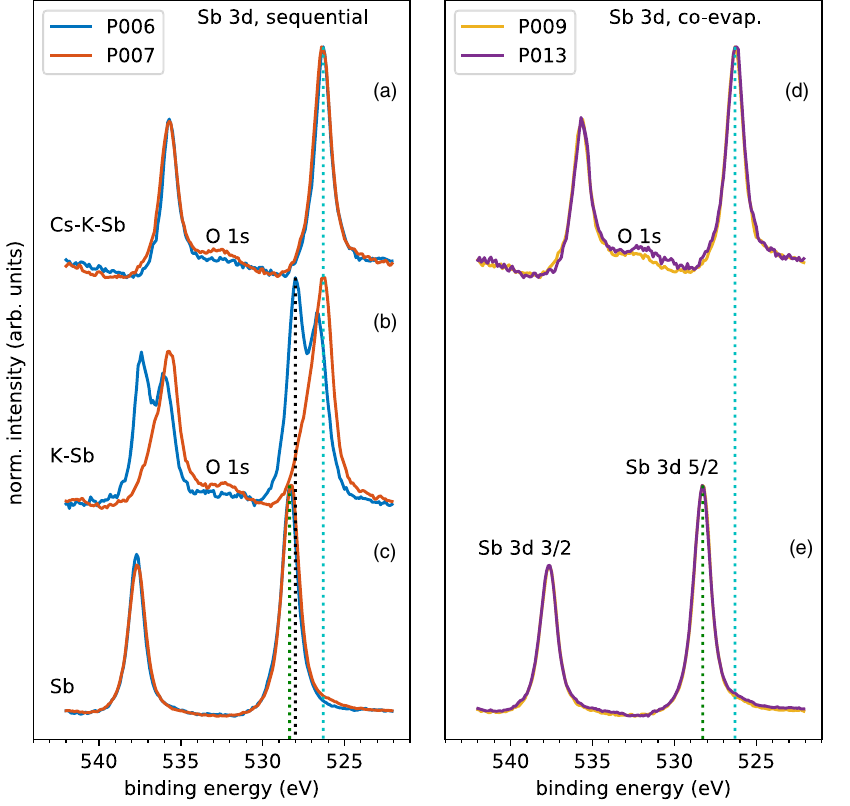
FIG. 2. Comparison of the Sb 3d spectra of four samples, two grown sequentially (left) and two by alkali metal coevaporation (right). In both processes the alkali metals were evaporated on a pure Sb layer (c, e). The Sb 3d spectrum of the K-Sb layer of P006 shows two peaks, indicating that the Sb has not fully reacted with K (b, blue line). The spectra of the Cs-K-Sb layers are identical for all samples (a and